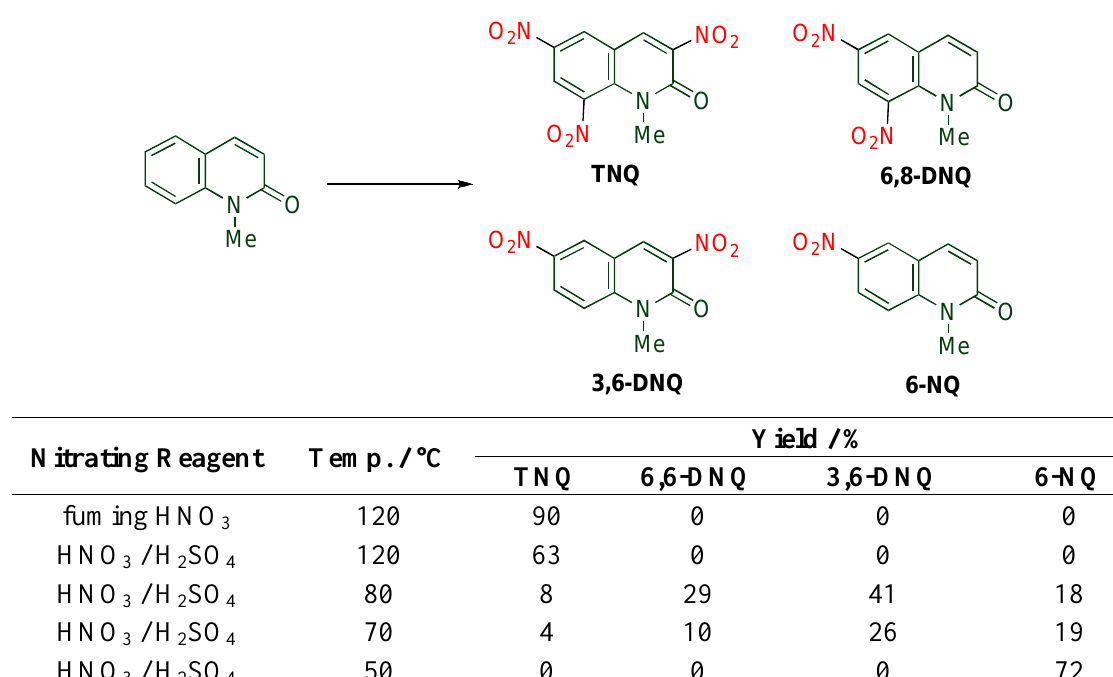
Table 1. Preparation of nitroquinolones by nitration of